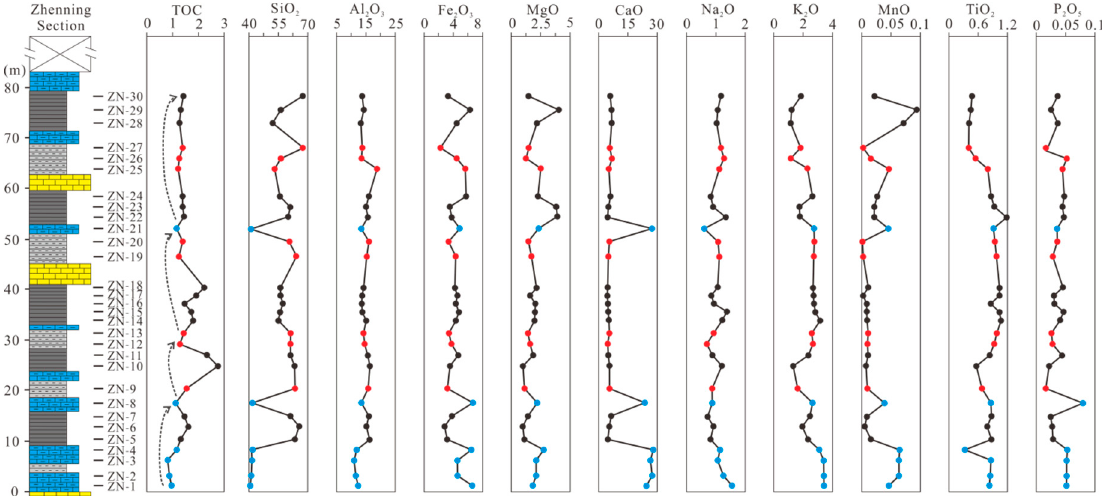
Figure 4. Vertical variation of major elements of the black rock series samples (unit: wt%).